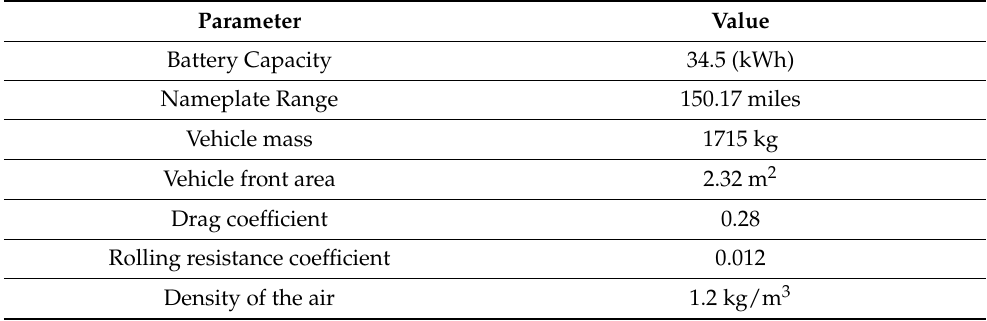
Table 2. Nissan Leaf 2019